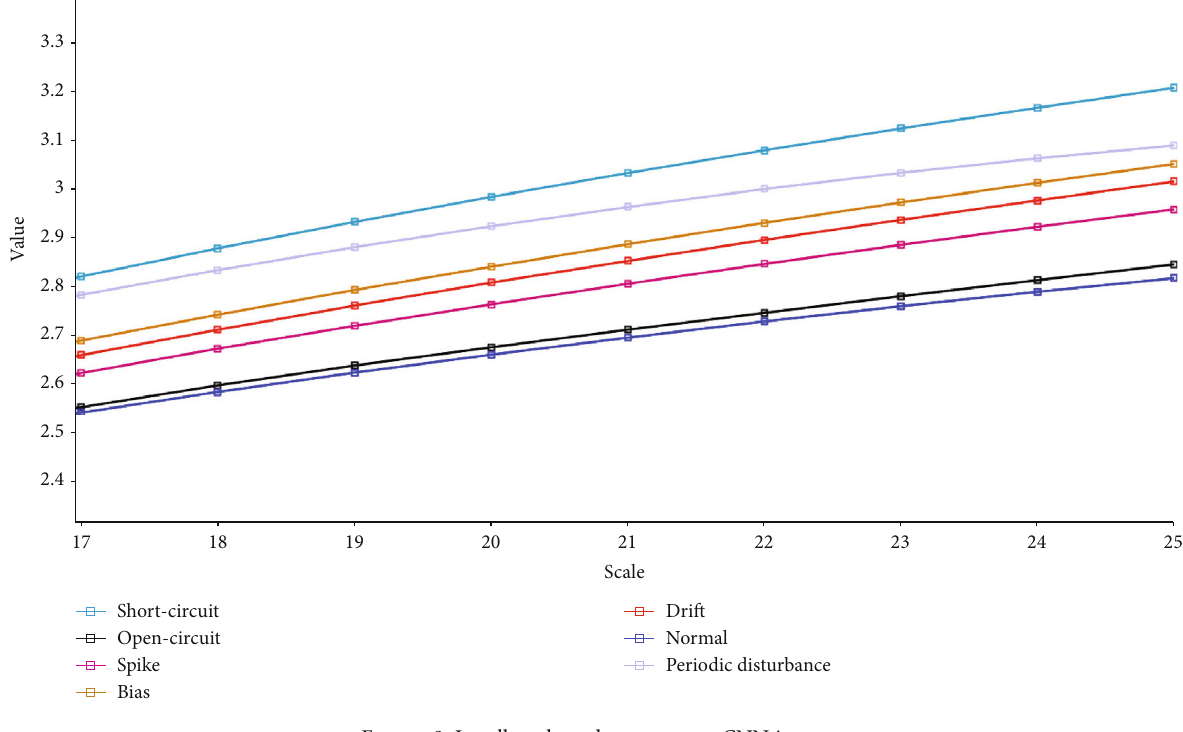
Figure 9: Locally enlarged spectrum as CNN